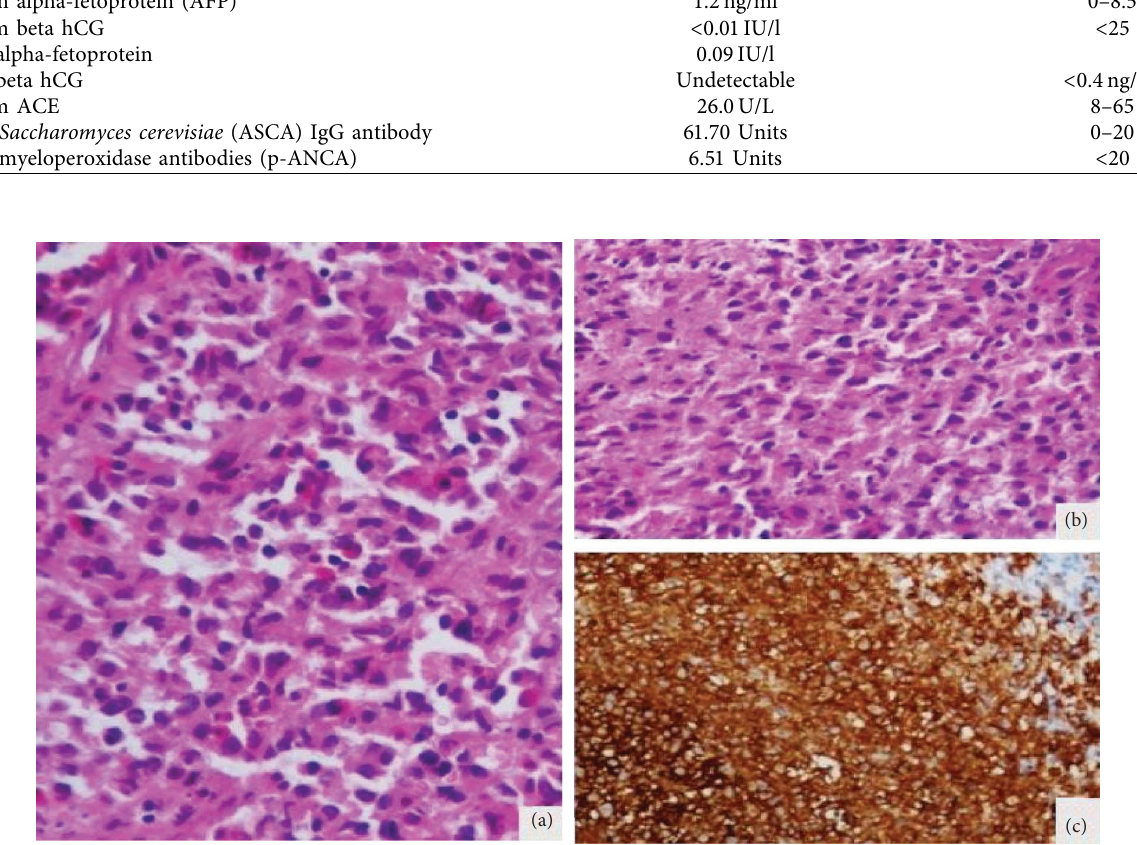
Figure 3: A panel of photomicrograph of perianal lesion showing sheets of epithelioid like cells with abundant amount of eosinophilic cytoplasm having mildly pleomorphic round to oval nuclei with nuclear grooving. Admixed with these cells are scattered eosinophils, lymphocytes, and plasma cells (a) (HE, x25). (b) Te cell morphology is brought out better in high-power photomicrograph (HE, x400). (c) Immunohistochemical staining showing atypical histiocytic cells positive for CD1a, Langerin, and S-100 (not shown) confrming